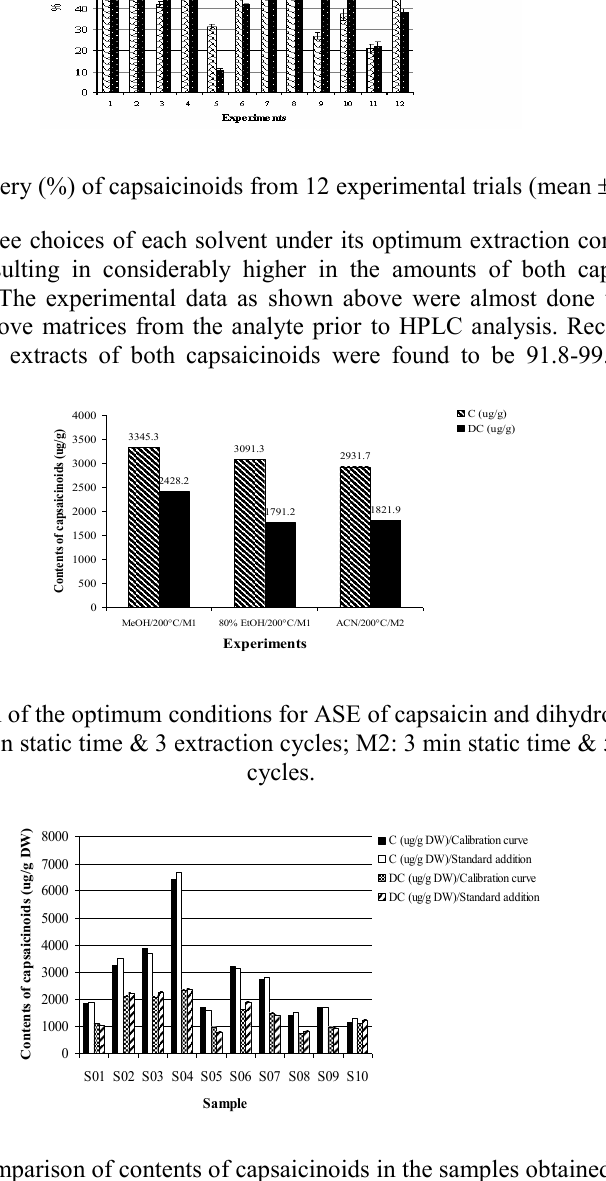
Figure 6. Comparison of contents of capsaicinoids in the samples obtained between calibration curve and standard addition